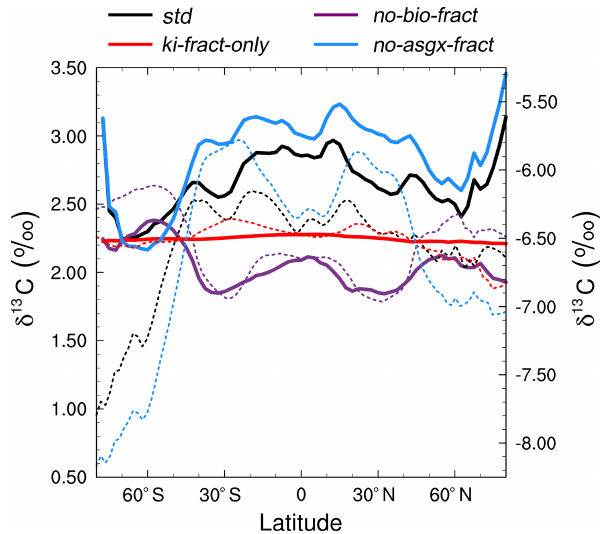
Figure 6. Zonally averaged mean annual surface δ 13 C DIC at the end of the sensitivity experiment spin-up simulations (years 9900 to 10000). The std (black) and no-bio-fract (purple) simulations use the left-hand axis, whilst the ki-fract-only (red) and no-asgx-fract (blue) simulations use the right-hand axis. The dotted lines are the equivalent simulations conducted by Schmittner et al. (2013) with the UVic ESM: std (black) and no-bio (purple) on the left-hand axis; ki-only (red) and const-gasx (blue) on the right-hand axis.